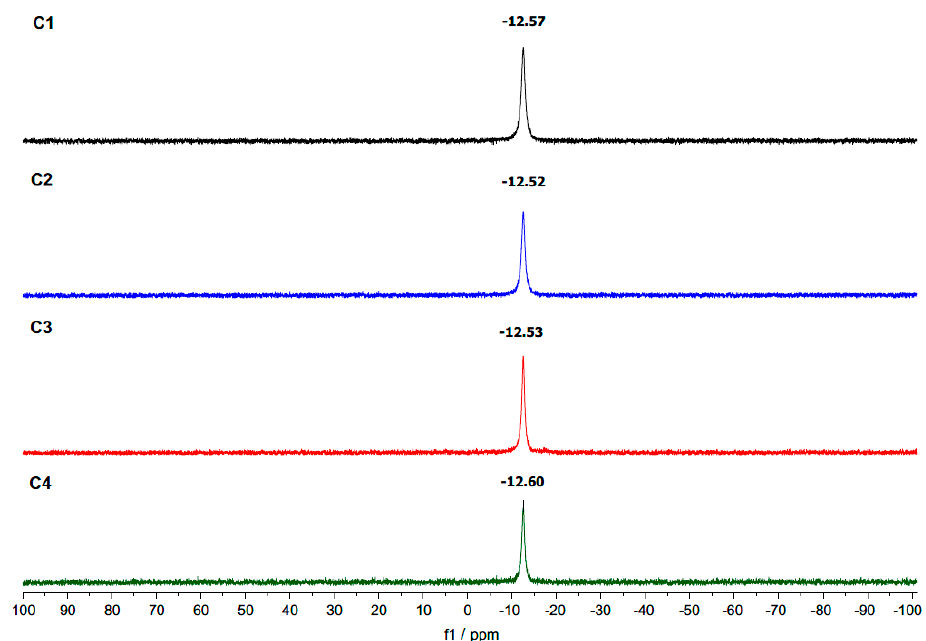
Figure 3. Comparison of the 31 P{ 1 H}-NMR spectra (at 162 MHz, in CD 3 CN) of the heteroleptic copper complexes C1 – C4 (from top to bottom).